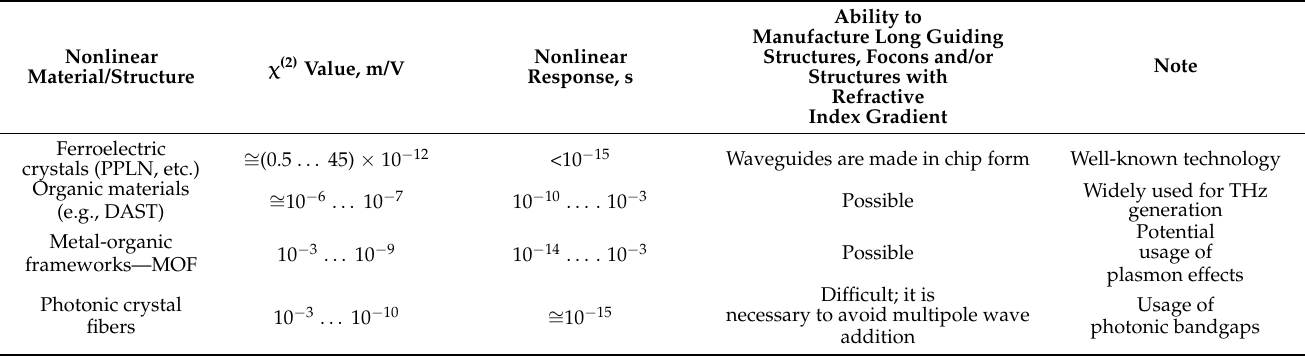
Table 1. Comparison of the considered nonlinear